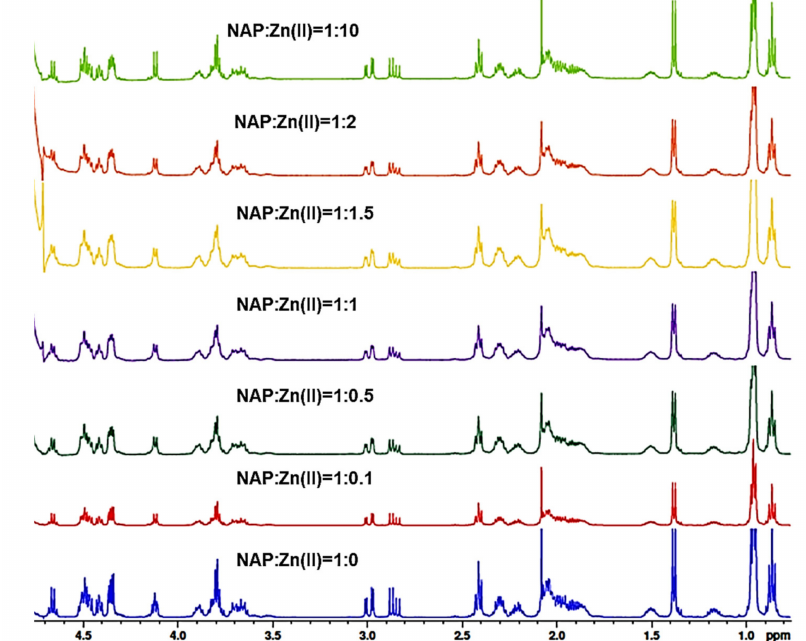
Figure 6. 1 H-NMR spectrum in the aliphatic region of NAP peptide titrated with increasing amounts of Zn 2+ at pH =